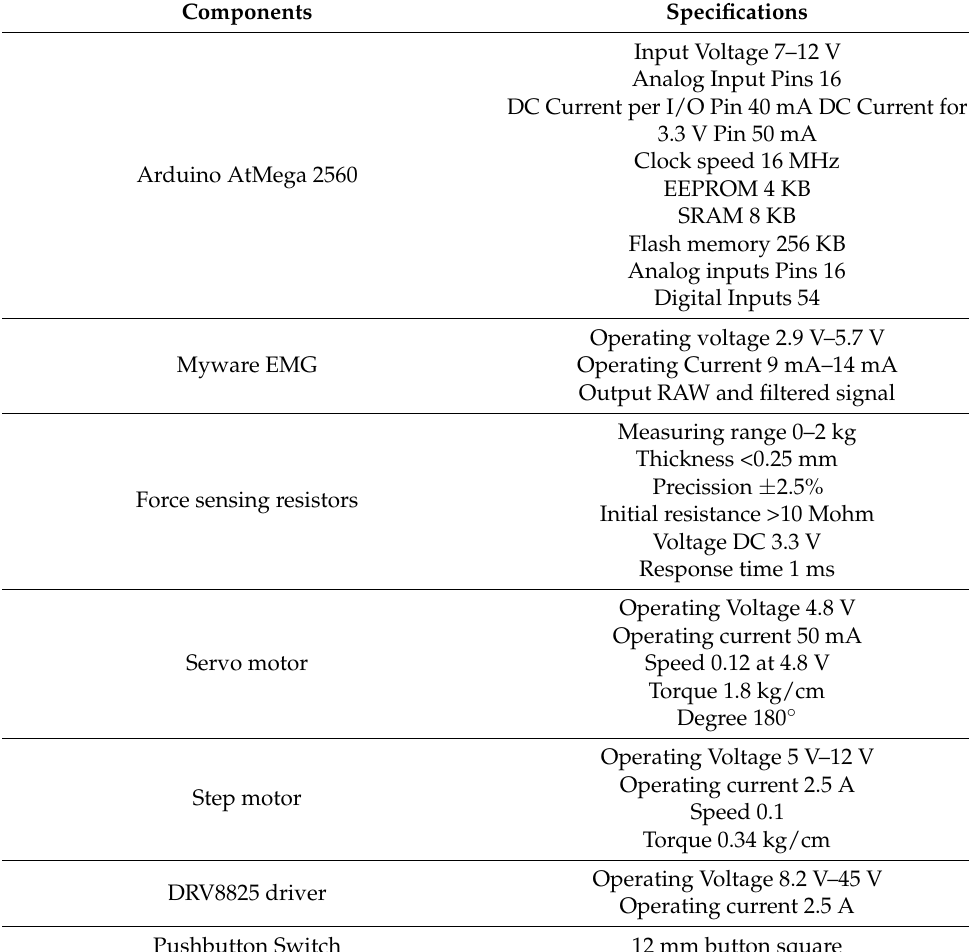
Table 3. Electronic